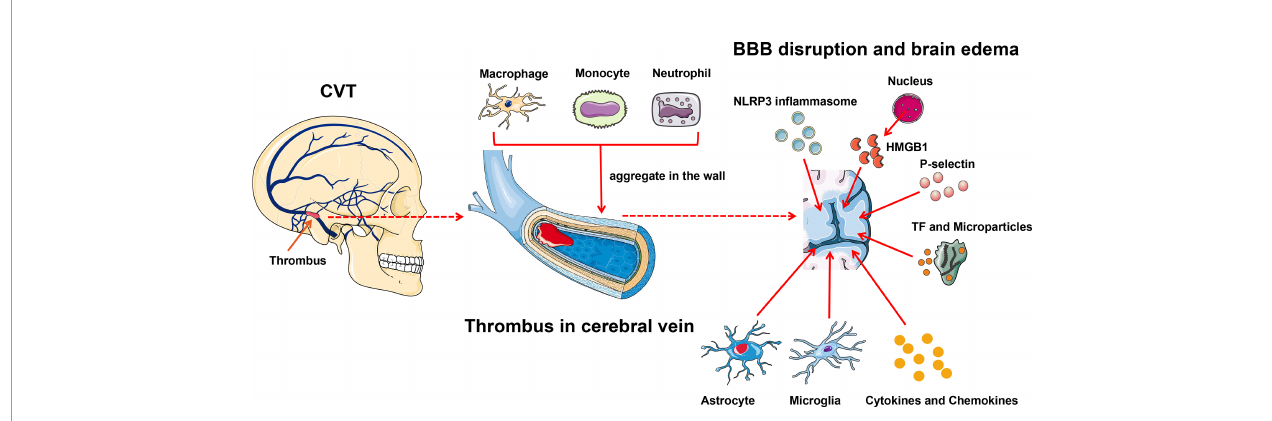
FIGURE 3 | In fl ammation exacerbates CVT-induced brain injury. Leukocyte – endothelial cell adhesion contributes to brain damage after CVT. Initially, neutrophils aggregate in the venous wall followed by monocytes and macrophages; meanwhile, microglia and astrocyte in fi ltrate into the damaged tissue. And then, cytokines, chemokines, and other in fl ammatory factors such as TNF- a are released to elicit an in fl ammatory reaction. P-selectin and activated TF within microparticles further amplify the brain tissue injury. NLRP3 is involved in the in fl ammatory reaction post-CVT through eliciting caspase-1 to cleave pro-IL-1 b and pro-IL-18 to their active forms. HMGB1, which is released from the nucleus, can induce endocytosis and generate proin fl ammatory factors to further damage the brain tissue. BBB, blood – brain barrier; CVT, cerebral venous thrombosis; HMGB1, high-mobility group box 1; TF, tissue